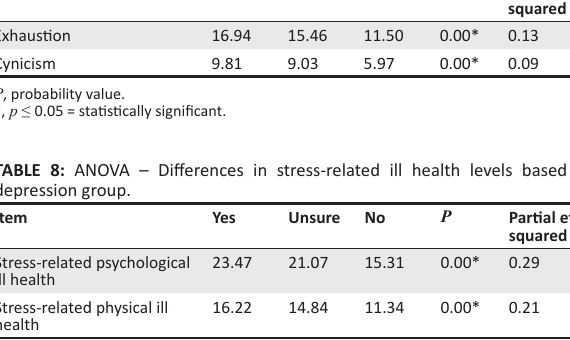
TABLE 7: ANOVA – Differences in burnout levels based on depression group. Item Yes